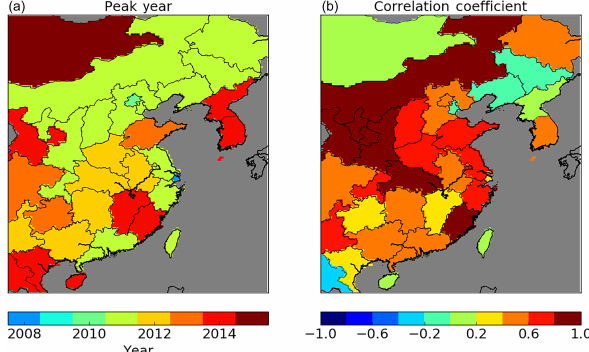
Figure 5. The peak year (a) of the average annual NO x emis- sions from the four satellite-derived inventories (DECSO-OMI, DECSO-GOME2a, EnKF-CHASER and EnKF-MIROC) for var- ious provinces and regions. (b) The map image shows the mini- mum temporal correlation coefficient of all combinations of the four emission datasets.